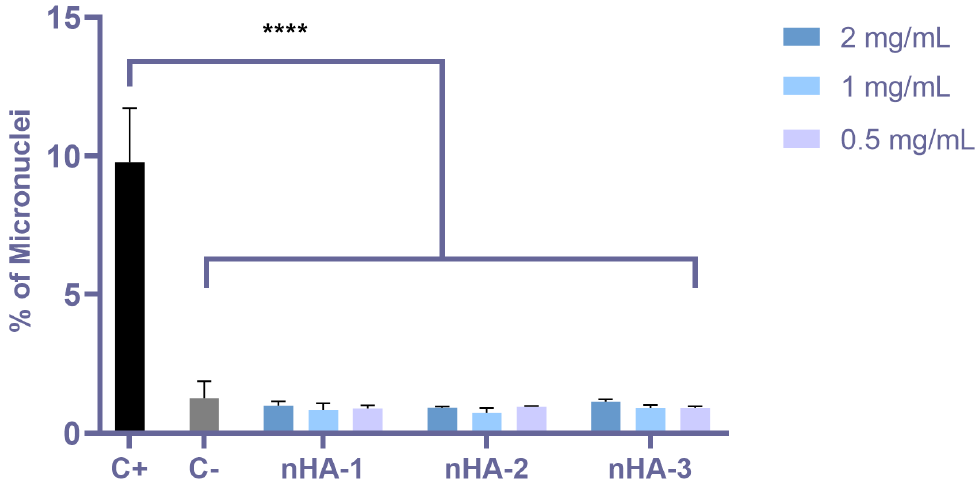
Figure 7. Genotoxicity assessment of the three nHA samples according to the OECD 487 in V79 cells. The graph shows the % of micronuclei formation in stained V79 cells. The concentrations of the three nHAs used were 0.5, 1, and 2 mg/mL. Positive control (C+): 400 µ M methyl methane sulphonate (MMS); negative control (C − ): cells only. Micronuclei were measured in 2000–3000 cells in each experiment. The values represent means ± standard deviation of triplicates of three independent experiments (n = 9). The asterisk (****) designates significant differences of all three nHAs and the TCPS control (C − ) compared to the MMS positive control (C+) ( p < 0.0001).